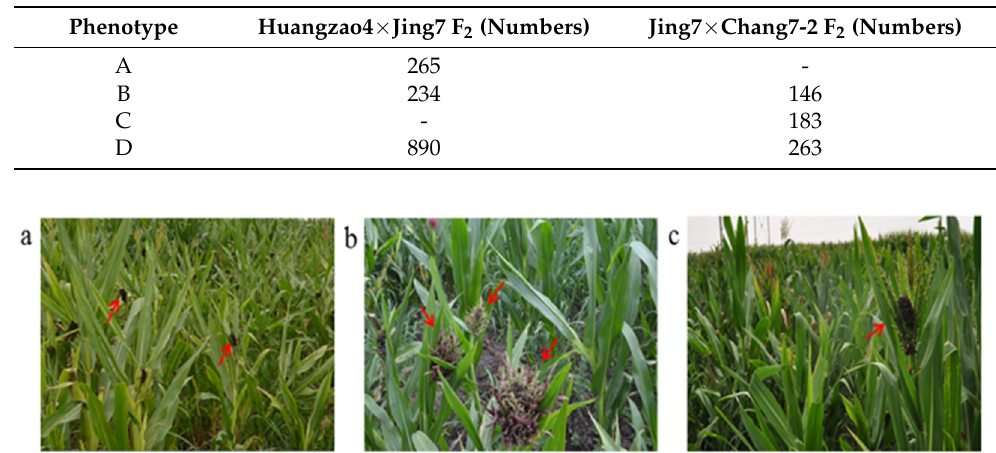
Figure 3. Different tassel symptoms of plants infected with Sporisorium reilianum in F 2 populations: ( a ) typical Huangzao4 plants in Huangzao4×Jing7 F 2 population; ( b ) typical Jing7 plants in the Huangzao4×Jing7 F 2 population; ( c ) typical Chang7 ‐ 2 plants in the Jing7×Chang7 ‐ 2 F 2 population. Table 1. Numbers of different tassel symptoms of maize infected with Sporisorium reilianum in two F 2 populations.